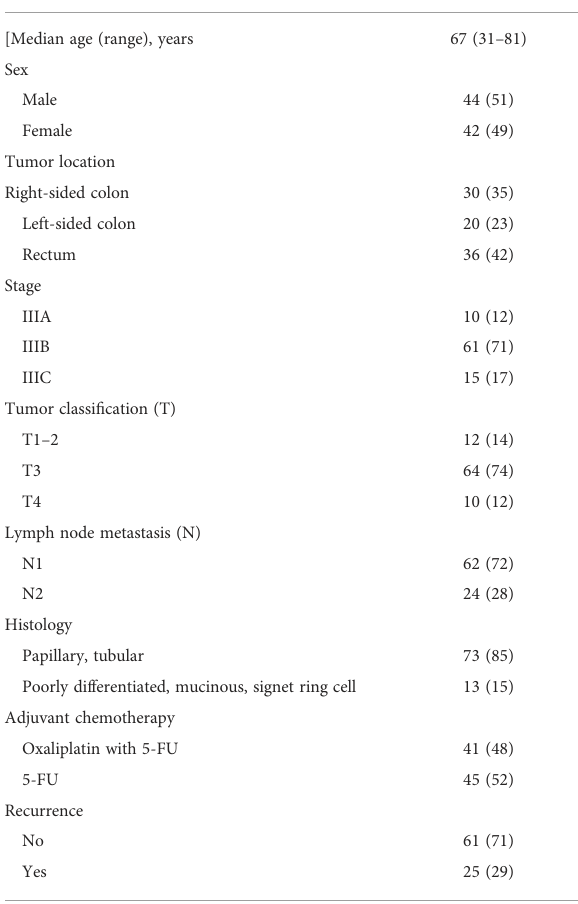
TABLE 1 Clinicopathologic characteristics of the study patients for mIHC ( n = 86).